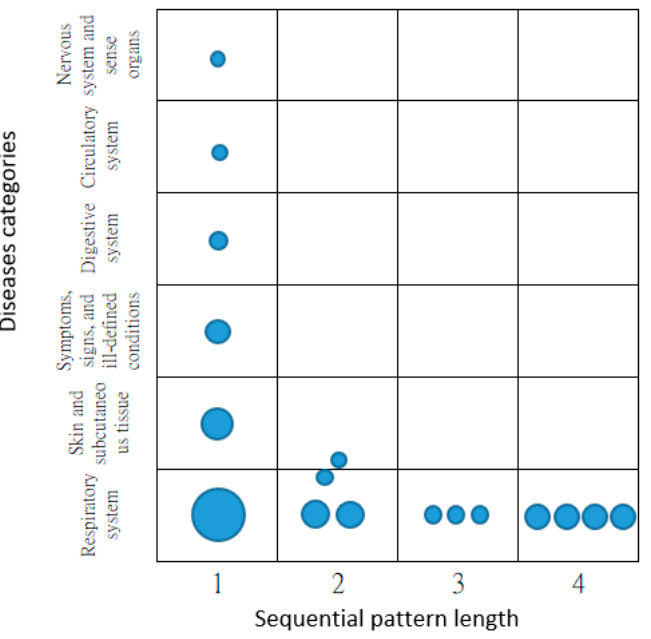
Figure 4. Disease categories by sequential pattern length.